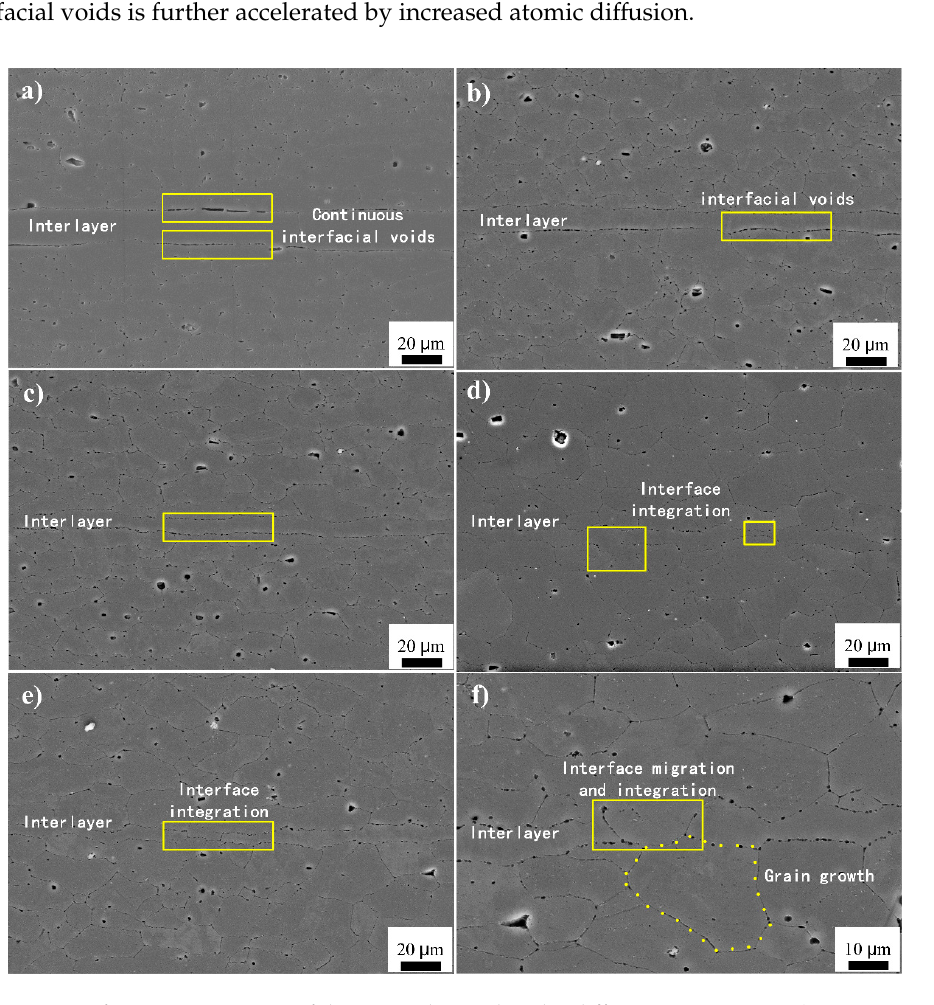
Figure 3. Interface microstructure of the joints obtained under different temperatures (6 MPa–60 min): ( a ) 430 °C; ( b ) 460 °C; ( c ) 490 °C; ( d ) 520 °C; ( e – f ) 550 °C.